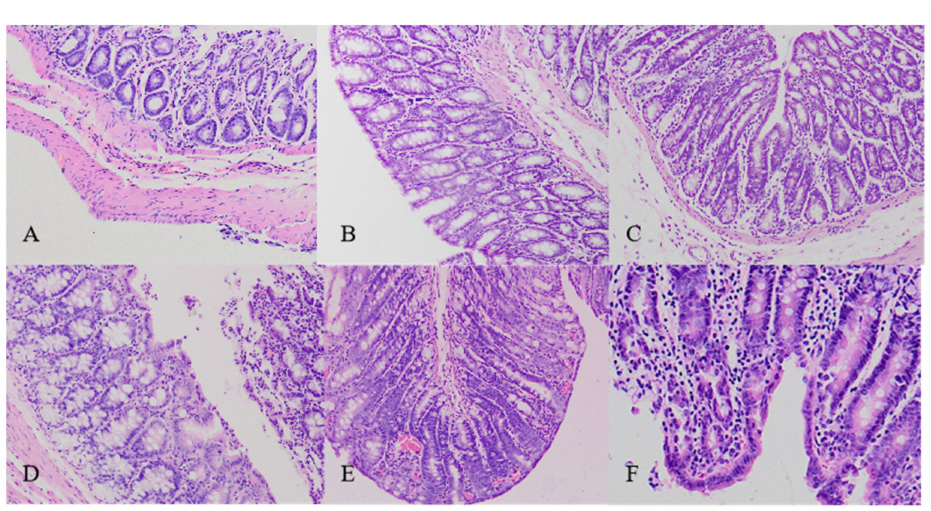
Figure 4. The H&E staining on the colons collected from the untreated rats and treated rats for over 6 days (original magnification 40 × ). The colon from ( A ) normal control rats. Rats treated with ( B ) low dose of senna anthraquinones. ( C ) high dose of senna anthraquinones. ( D ) low dose of rhubarb anthraquinones. ( E ) high dose of rhubarb anthraquinones. ( F ) sennoside